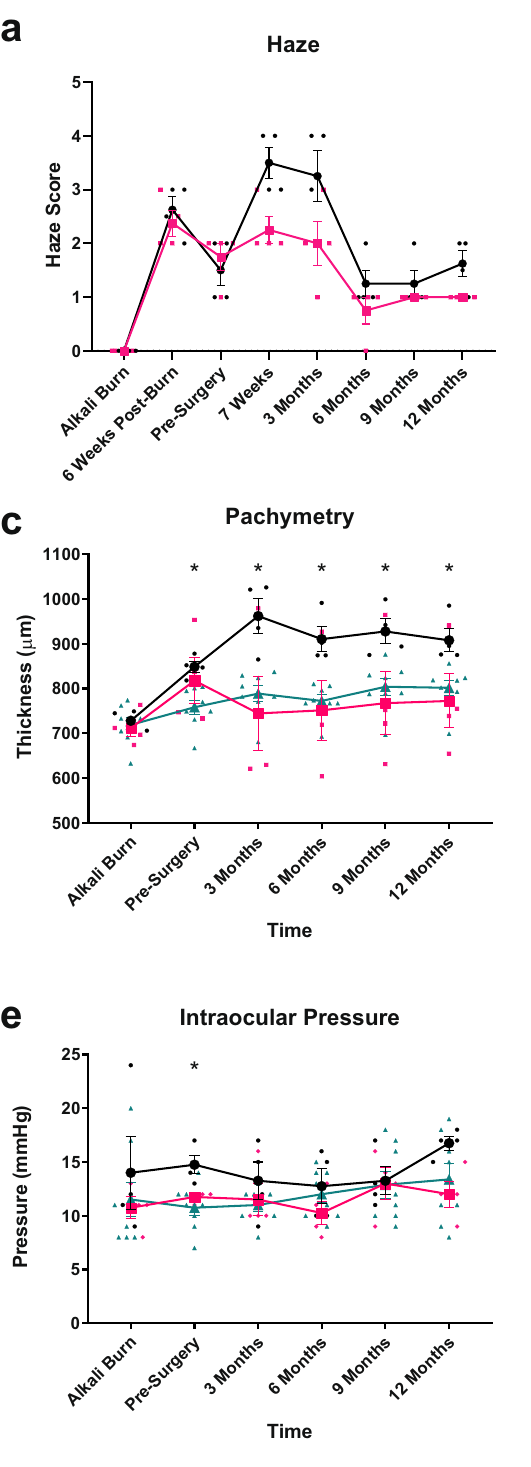
Electron microscopy on regenerated mini-pig neo-corneas . Serial block face scanning electron microscopy (SBF-SEM) (Fig. 7a – f) and transmission electron microscopy (Fig. 7g – i) showed that both neo-corneas resembled naïve corneas, except that the basal aspect of their basal epithelial cells showed numerous invaginations. SBF-SEM also revealed a more regular lamellar keratocyte arrangement in CLP-PEG-MPC neo-corneas (Fig. 7a, d) resembling that of the healthy, unoperated controls (Fig. 7c, f). However, the CLP-PEG neo-corneas had more